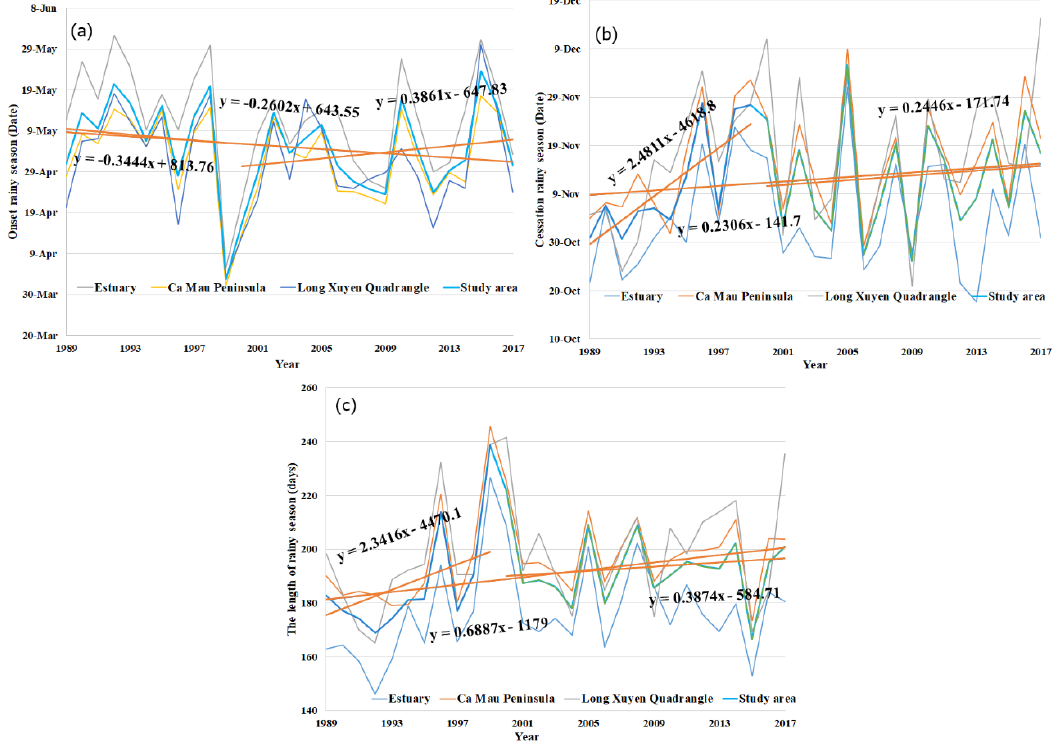
Figure 4. The date of onset of the rainy season (ORD) ( a ), the cessation date of the rainy season (CRD) ( b ), and the length of the rainy season (LRS) ( c ) for the entire study area and for the estuary, CMP, and LXQ subregions.